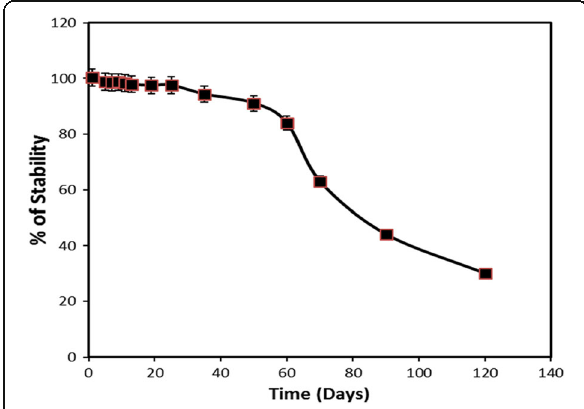
Fig. 8 The life span profile of the fabricated V. cholerae DNA sensing electrode. The electrode was stored in 0.05 M potassium phosphate buffer (pH 7.0) at 4 °C after every DPV measurement was